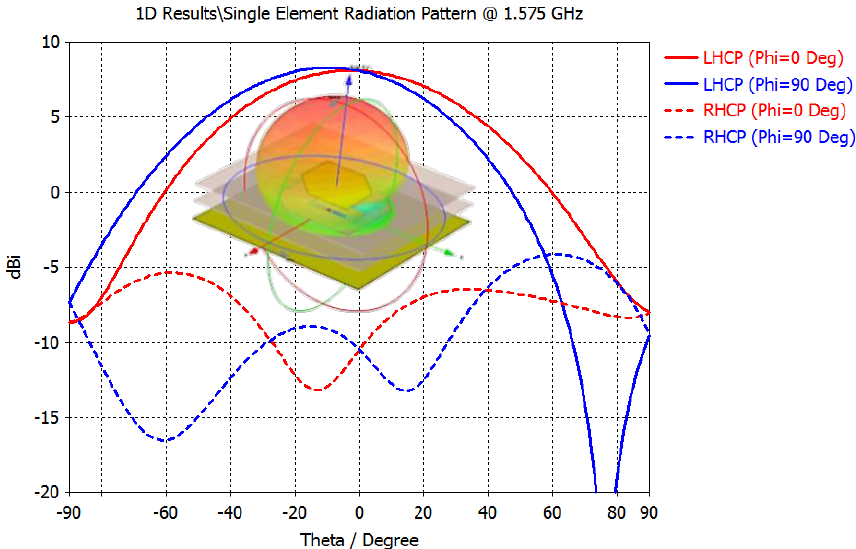
Figure 5. Radiating element simulated radiation pattern at 1.275 GHz.